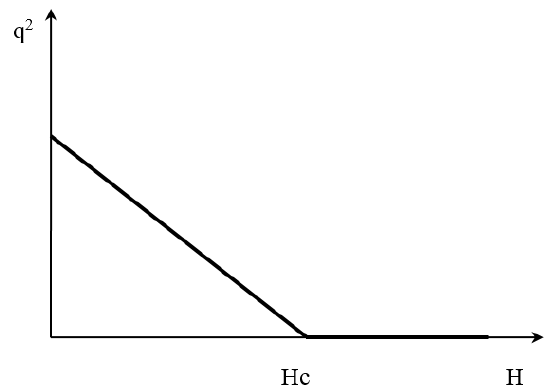
Figure 2. Graphical solution of Equation (5).